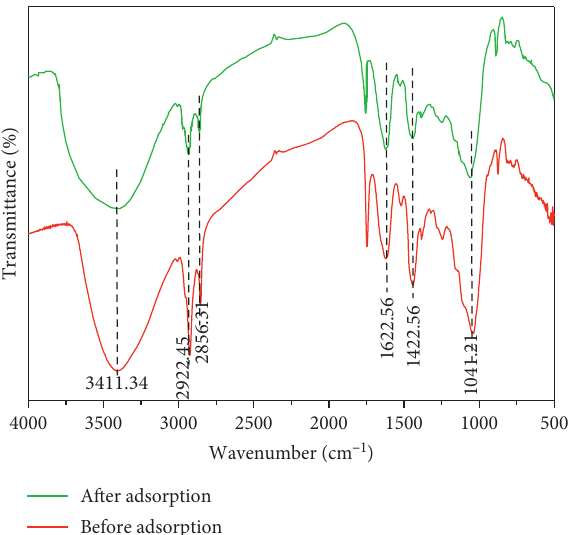
Figure 3: Infrared spectrum of RDP before and after RBB adsorption.